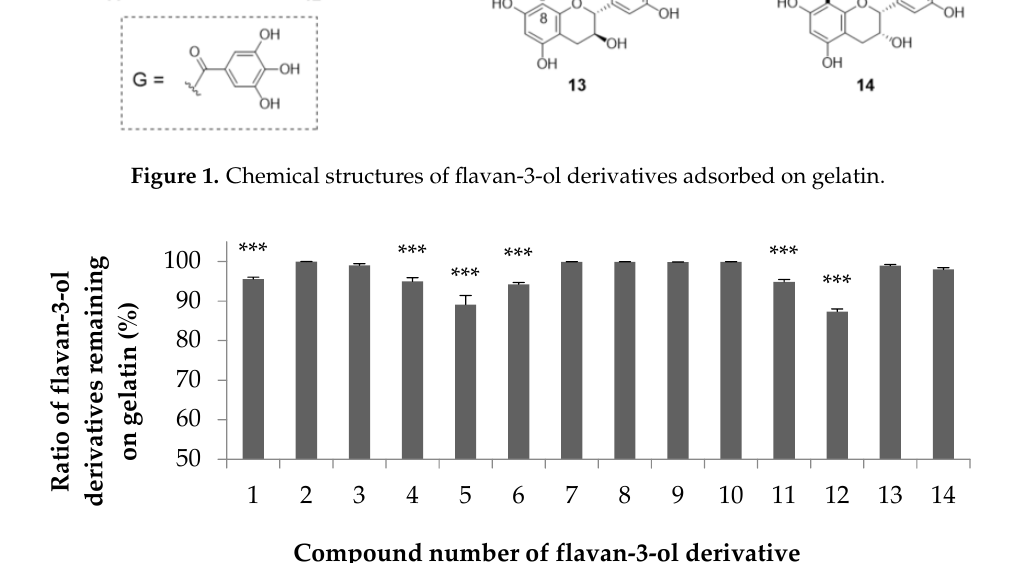
Figure 2. Proportions of flavan-3-ol derivatives 1 – 14 adsorbed on heat-stabilized gelatin after incubation. Error bars represent the SD of the mean ( n = 6). *** p < 0.001 vs. epicatechin ( 3 ), in Student’s t test. Compounds 2 , 7 , 8 , 9 , 10 , 13 and 14 did not show significantly different data from that of compound 3